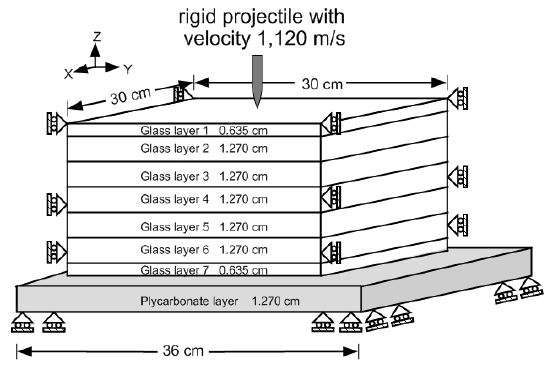
Figure 2. The geometry of the multi-layer glass target and boundary conditions used in the peridynamic